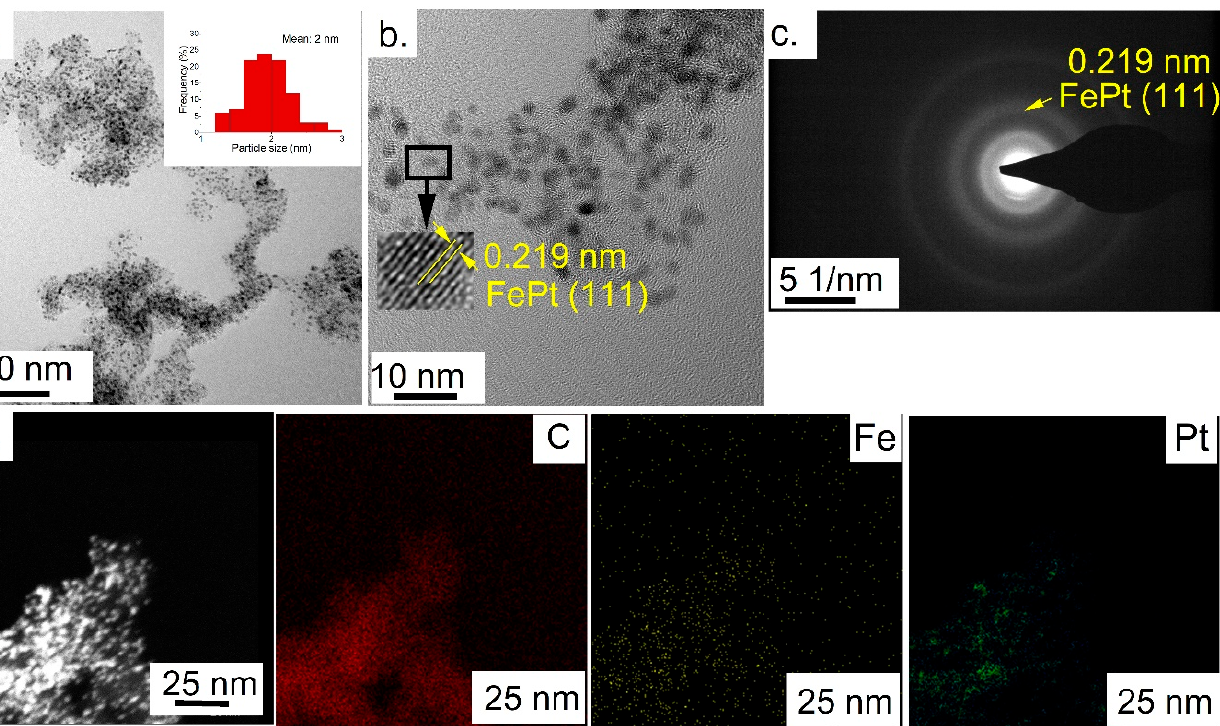
Figure 1. ( a , b ) HRTEM images, ( c ) SAD, and ( d ) EDS elemental mapping of FePt/VC. The XRD pattern of as-synthesised FePt/VC revealed diffraction peaks at 40.2 and 68.0° assigned to fct FePt (111) and FePt (220) (Figure 2) [29,39]. The peak positions are shifted slightly towards higher diffraction angles compared to Pt/VC (Figure S3). This shift towards higher diffraction angles could be due to a decrease in the lattice spacing as a result of alloying Pt with the smaller Fe atom [40].